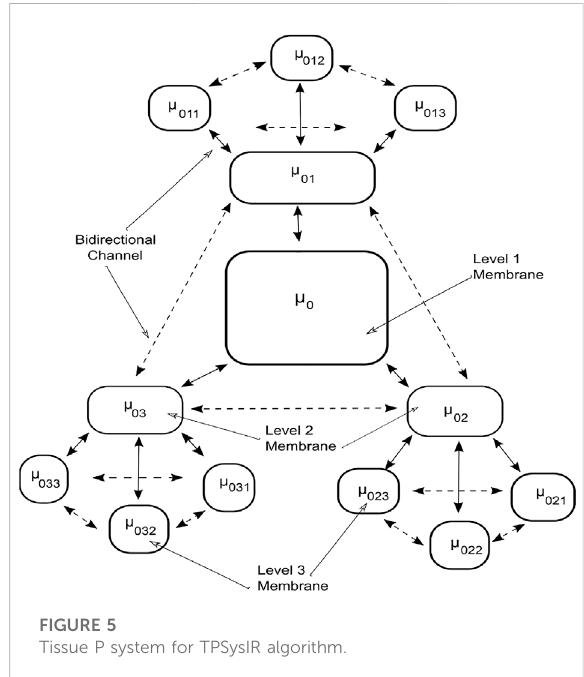
FIGURE 5 Tissue P system for TPSysIR